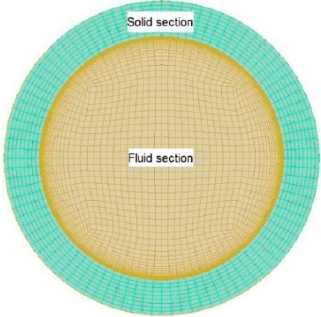
Figure 3. Computational meshes. Table 1. Initial/boundary conditions of simulations.